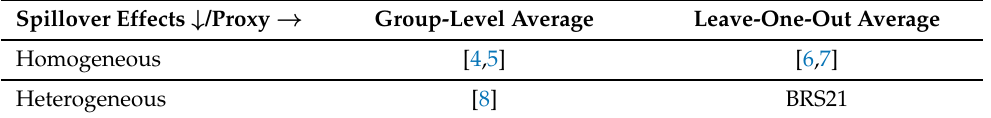
Table 2. Proxies employed in applications.